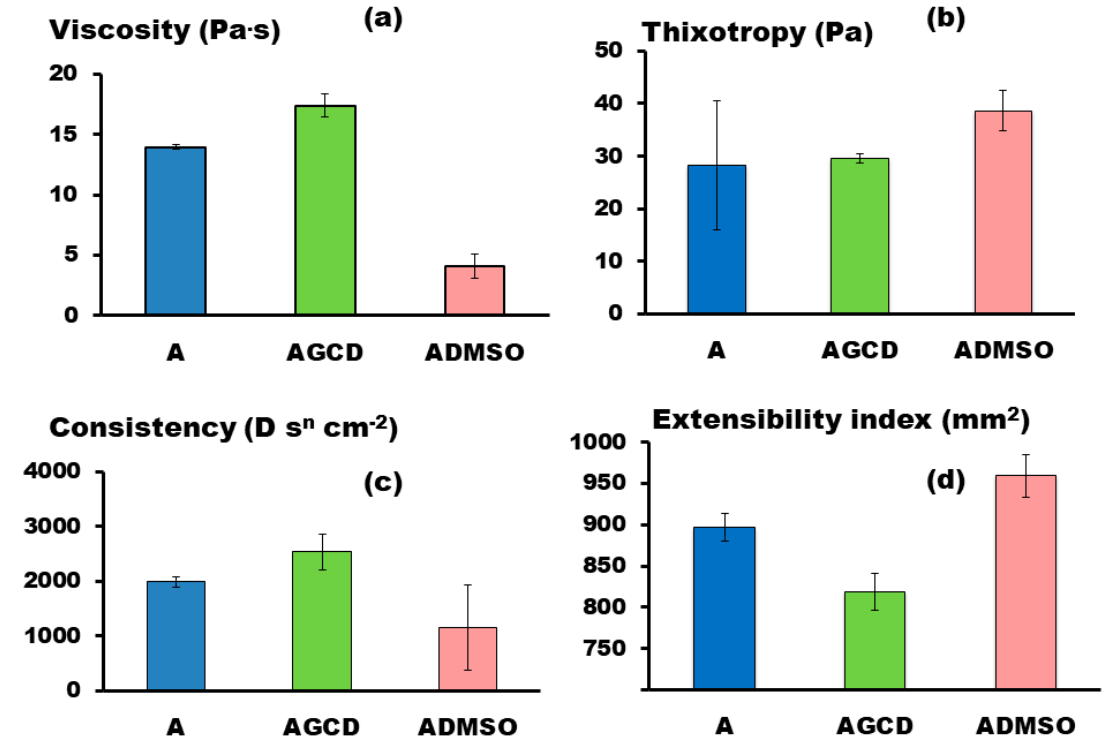
Figure 2. Mean results ± 95% confidence intervals corresponding to the rheological behavor of the three semisolid AmB tested formulations: ( a ) mean viscosity (Pa · s) at 15 rpm (significant differences, p < 0.01); ( b ) thixotropy (Pa) (no significant differences, p > 0.1); ( c ) consistency (D s n cm − 2 ) (significant differences, p < 0.01); ( d ) extensibility index (mm 2 ) (significant differences, p < 0.05). Key: (A) semisolid AmB simple reference formulation, (ADMSO) is an AmB reference formulation with DMSO and (AGCD) is an AmB formulation with γ -cyclodextrins. Statistics was performed with an analysis of variance (ANOVA) test (n = 3 samples for each formulation).